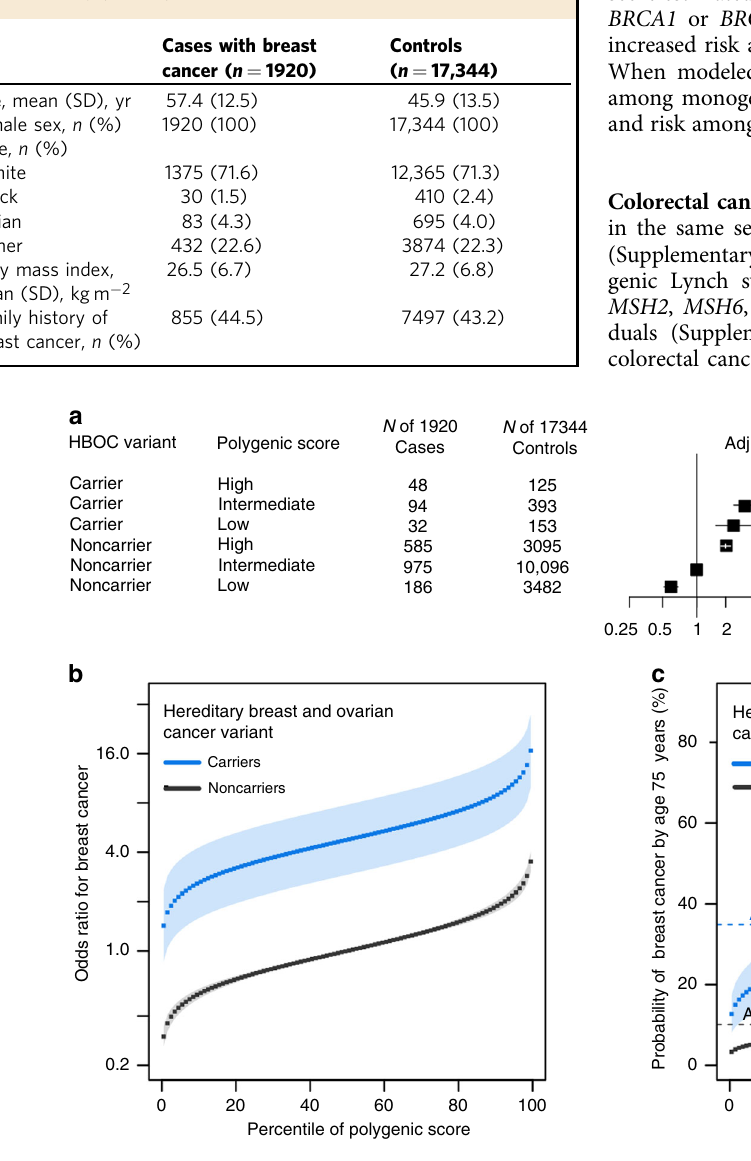
Table 2 Baseline characteristics of breast cancer case- control study